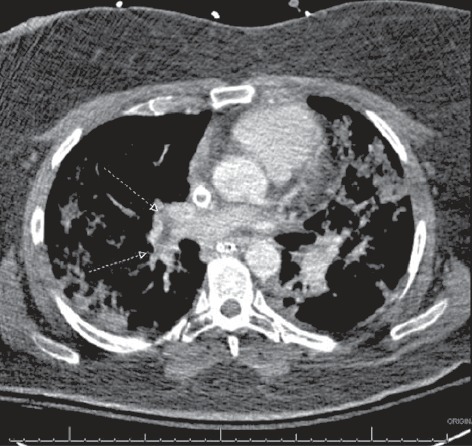
Computed tomography.